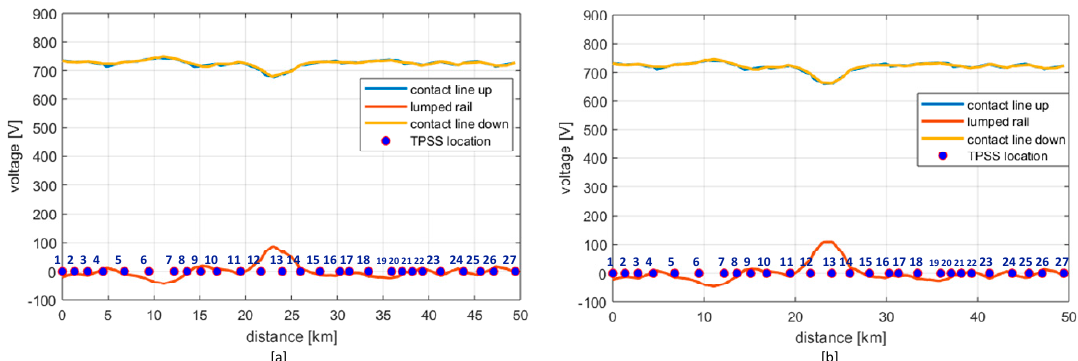
Figure 15. Network voltage against location: ( a ) Normal operation; ( b ) TPSS 13 is switched off.